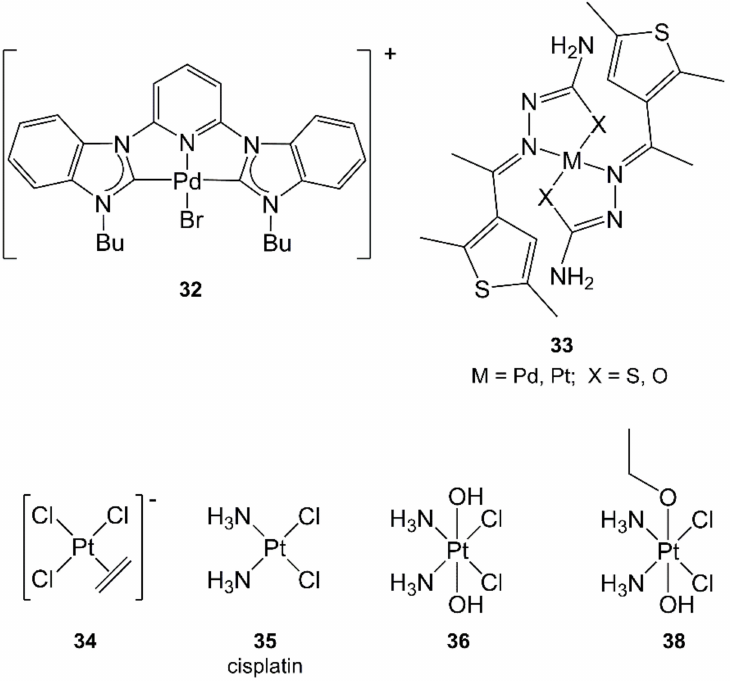
Figure 11. A selection of Pd and Pt complexes cited in the